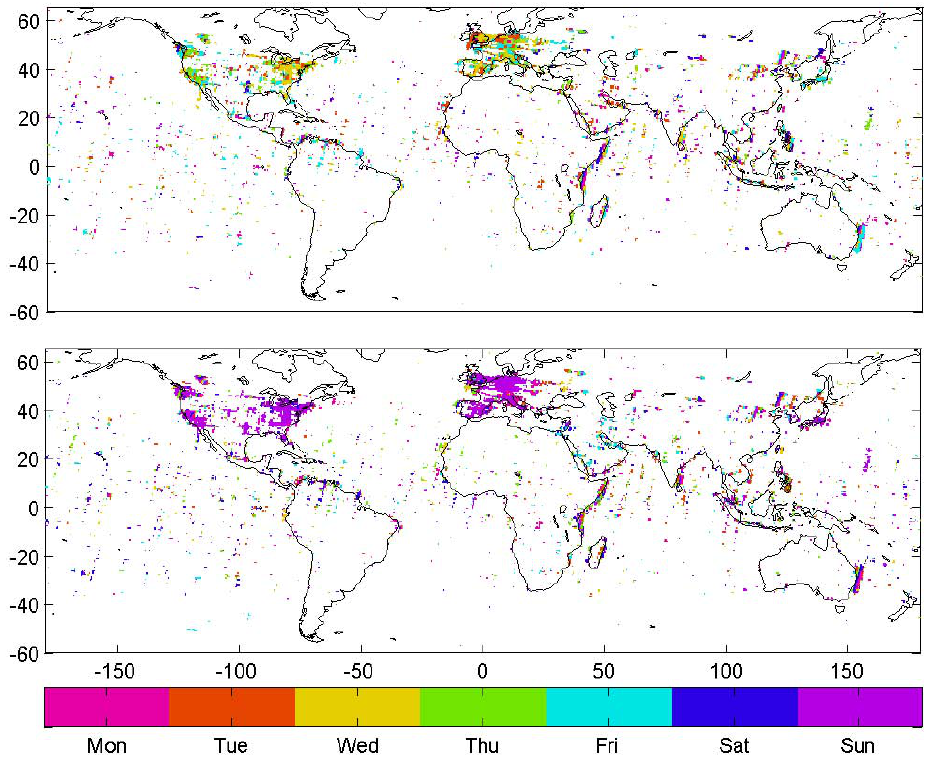
Fig. 6. Day of week with (a) maximum and (b) minimum TVCD. Only data of p-values less than 0.001 are shown.